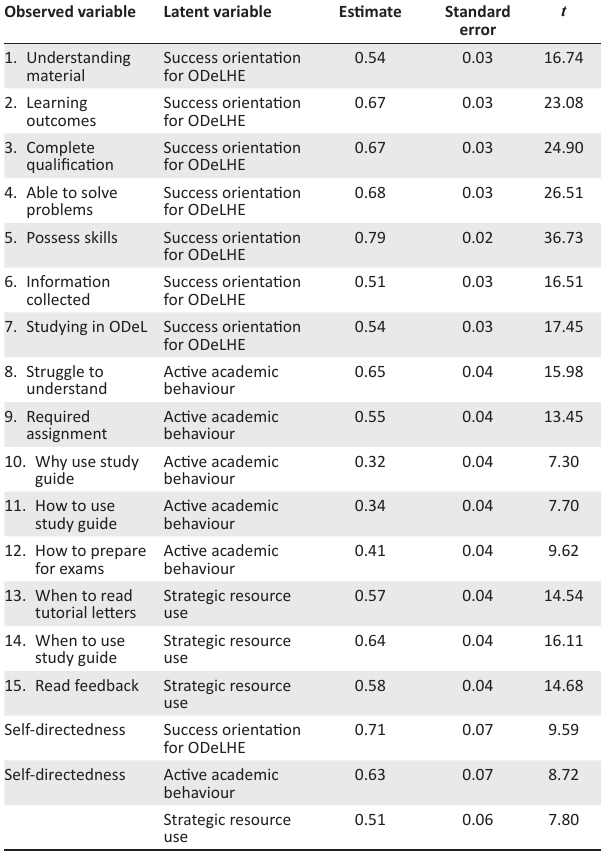
FIGURE 2: Adult Learner Self-Directedness Scale structural equation model (best-fitting TABLE 3: Adult learner self-directedness scale: Standardised factor coefficients best-fitting model. Observed variable